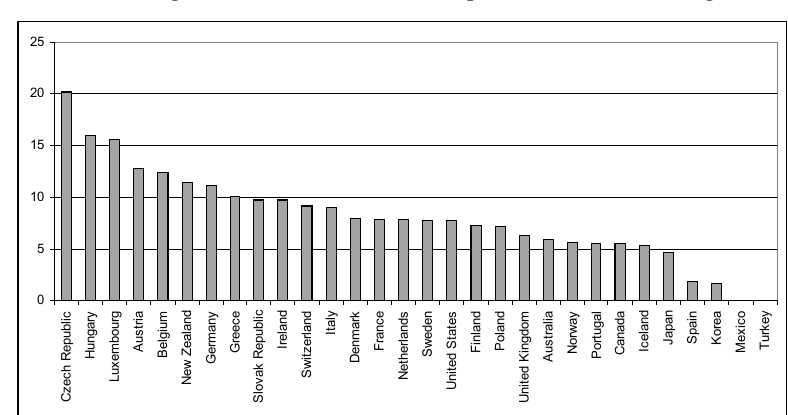
Figure 16 : Child benefit package Couple plus 2 (average and third average earnings) 2007. Percentage more than a childless couple on the same